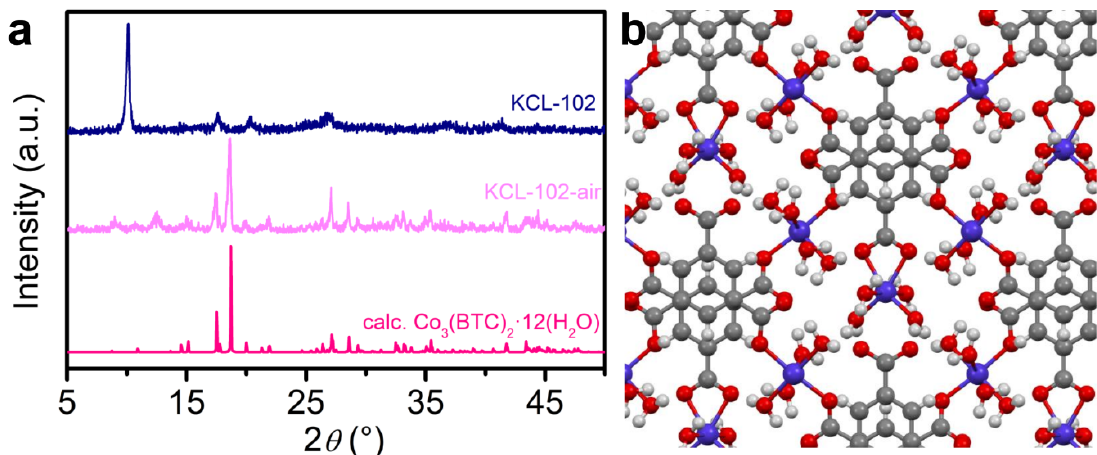
Figure 2. ( a ) XRD patterns of DMF-washed KCL-102 (blue line) and after leaving KCL-102 in the air for one week ( KCL- 102-air , light pink line). The calculated pattern of Co 3 (BTC) 2 ·12H 2 O using the structure reported in Ref. [46] is also shown for comparison (dark pink line). ( b ) View along [001] of Co 3 (BTC) 2 ·12H 2 O structure as reported in Ref. [46]. Color code: violet (Co), red (O), grey (C), white (H).